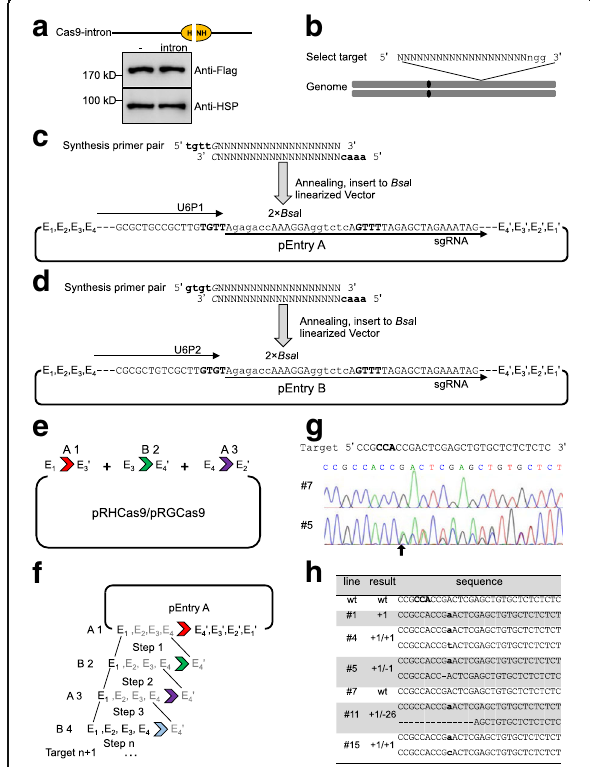
Fig. 5 Diagram of how CRISPR/Cas9 vectors were constructed and used to edit the rice IPA1 gene. a Western blot analysis of the Cas9-intron expression in rice protoplasts. HSP indicates the loading amount of each sample. b Target site selection for candidate genes in the rice genome. A 20-bp specific sequence followed by the PAM “ NGG ” structure is required. c and d Target cloning to the entry vectors. Synthesis of the primer pairs of the 20-bp specific target with the 4-bp adapters, and ligation with the Bsa I linearized pEntry A or pEntry B vector. e One-step ligation and f step-by-step ligation of multiple targets to pRHCas9/pRGCas9. Four pairs of isocaudamers, Pst I(E 1 )- Nsi I(E 1 ’ ), Xba I(E )- Spe I(E 2 ’ ), Bam HI(E 3 )- Bgl I(E 3 ’ ), and Sal I(E 4 )- Xho lI(E 4 ’ ) are marked. 2 The sgRNA cassettes with U6P1 and U6P2 in pEntry A and B should be used in turn. g Representative sequencing chromatogram of the CRISPR- IPA1 transgenic lines. Line #7, wild-type genotype; line #5, mutant genotype. h Representative gene editing results in the CRISPR- IPA1 transgenic